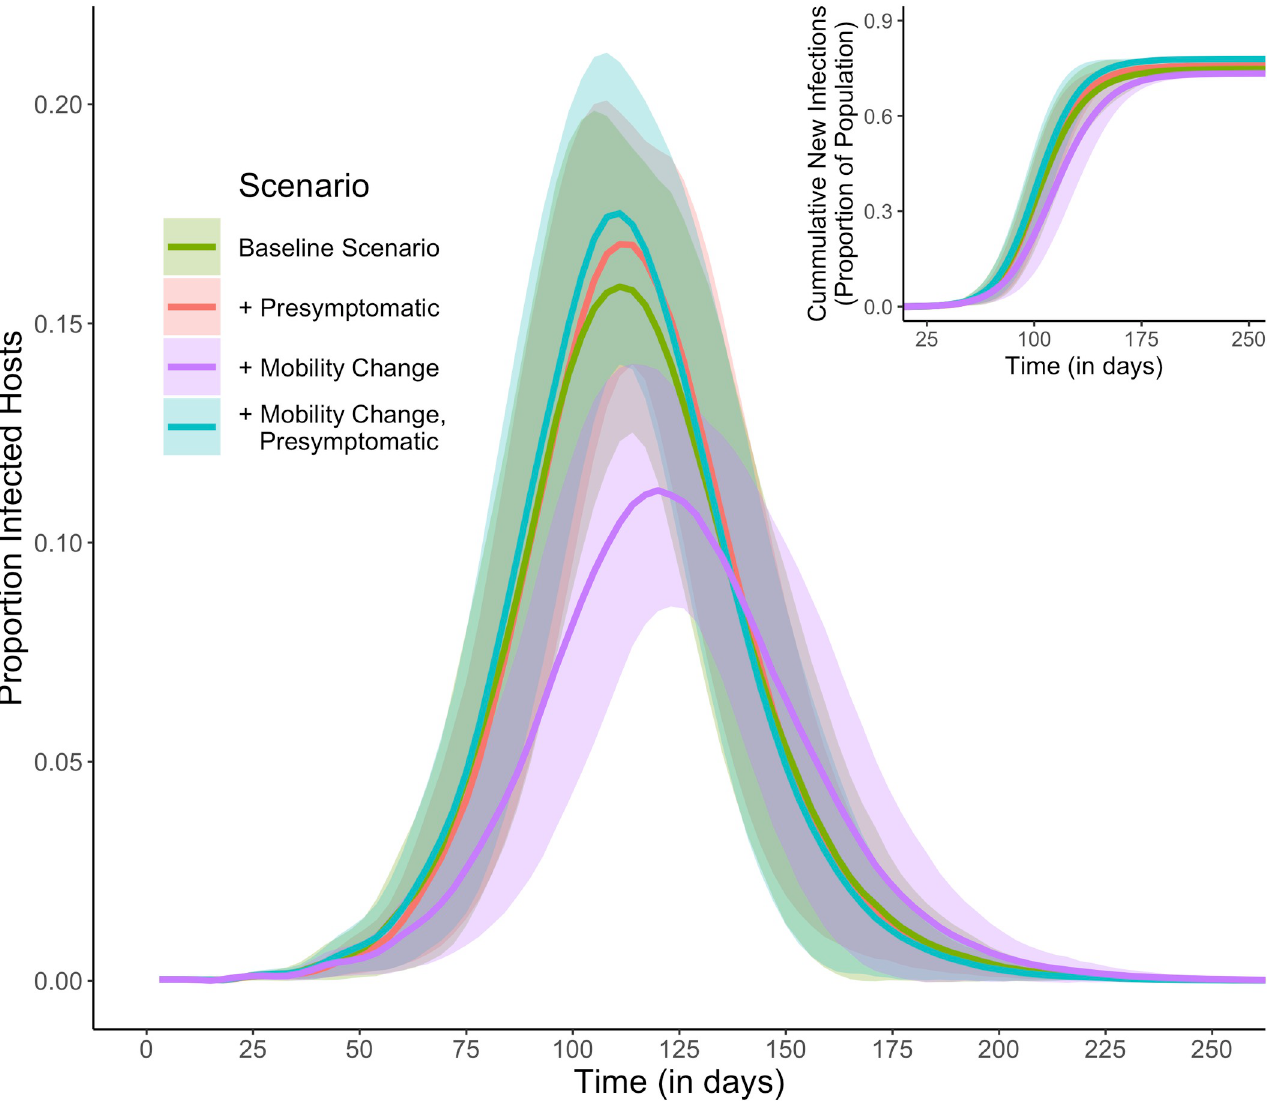
Fig 2. Predicted influence of disease-driven mobility reduction and pre-symptomatic transmission on DENV epidemic dynamics. For each scenario and for each time step, (main) the average proportion of infected hosts is calculated and (inset) the average proportion of cumulative infections is calculated. Averages are calculated across all simulation runs where an outbreak occurred, with standard deviations included in the shaded ribbons. The baseline scenario is one with no mobility change and no pre-symptomatic period.